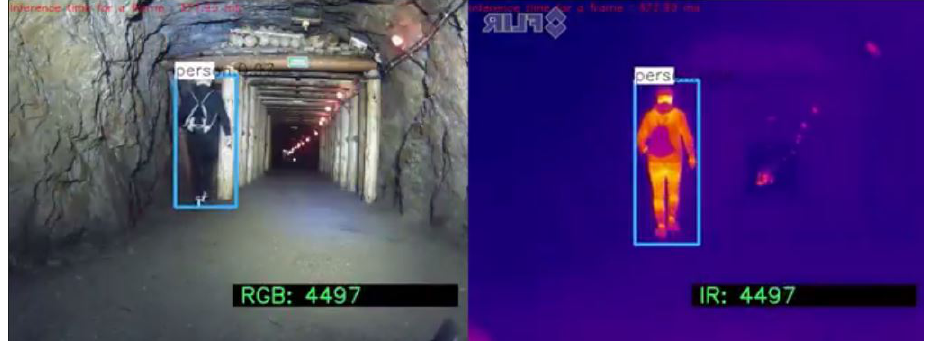
Figure 12. Correct detection in both images with the You Only Look Once (YOLO) algorithm.